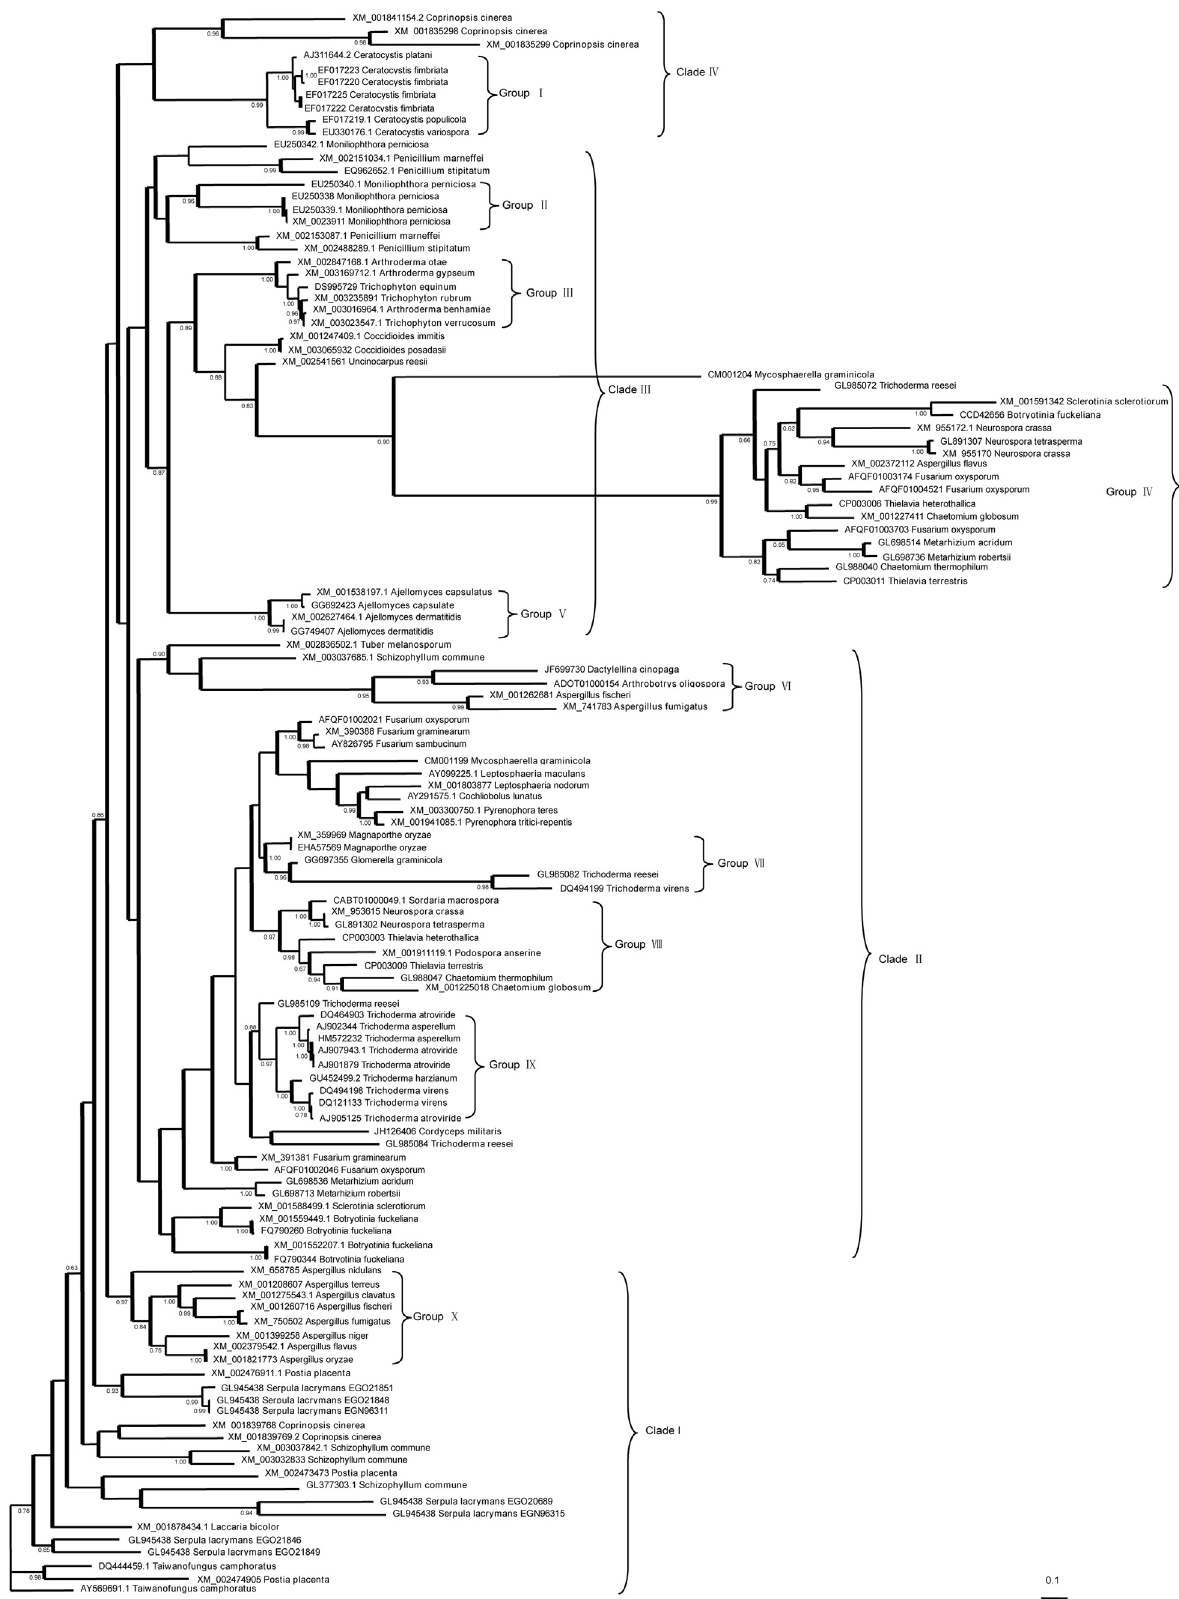
Figure 1 - Phylogenetic relationship of genes encoding proteins in the cerato-platanin family. The nodes corresponding to adaptive evolution are shown as bold lines. Posterior probabilities > 0.6 are shown. The sequences encoding putative proteins with glycosylation sites are indicated in